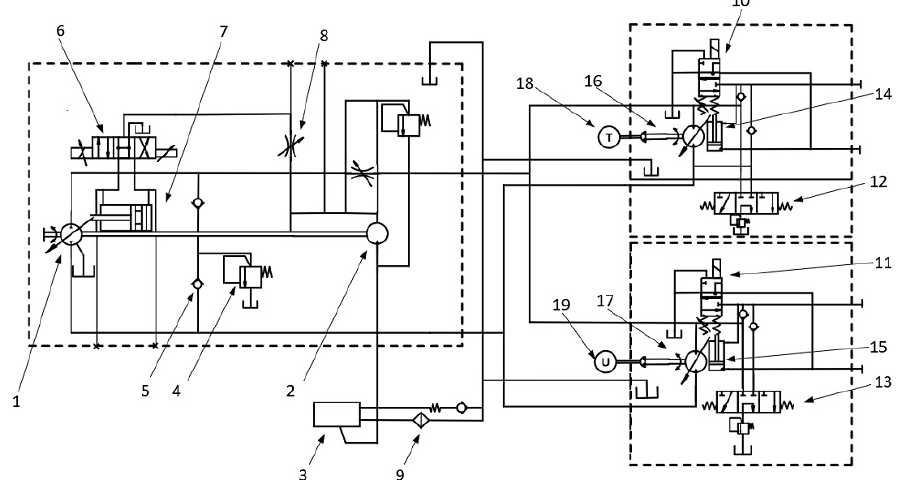
Figure 1. Transmission principle diagram of hydraulic traveling system. 1. Hydraulic pump; 2.